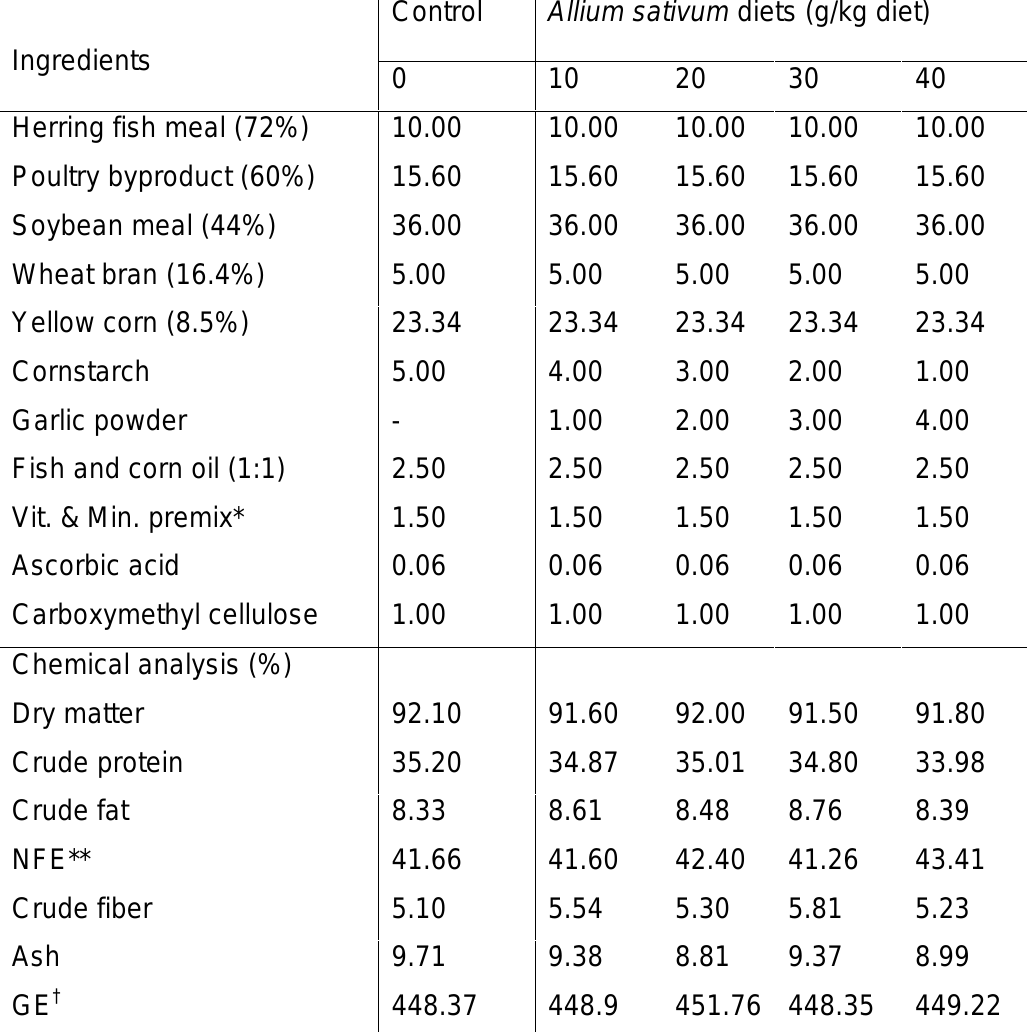
Table 1: Constituents and proximate chemical composition of experimental diets (dry matter